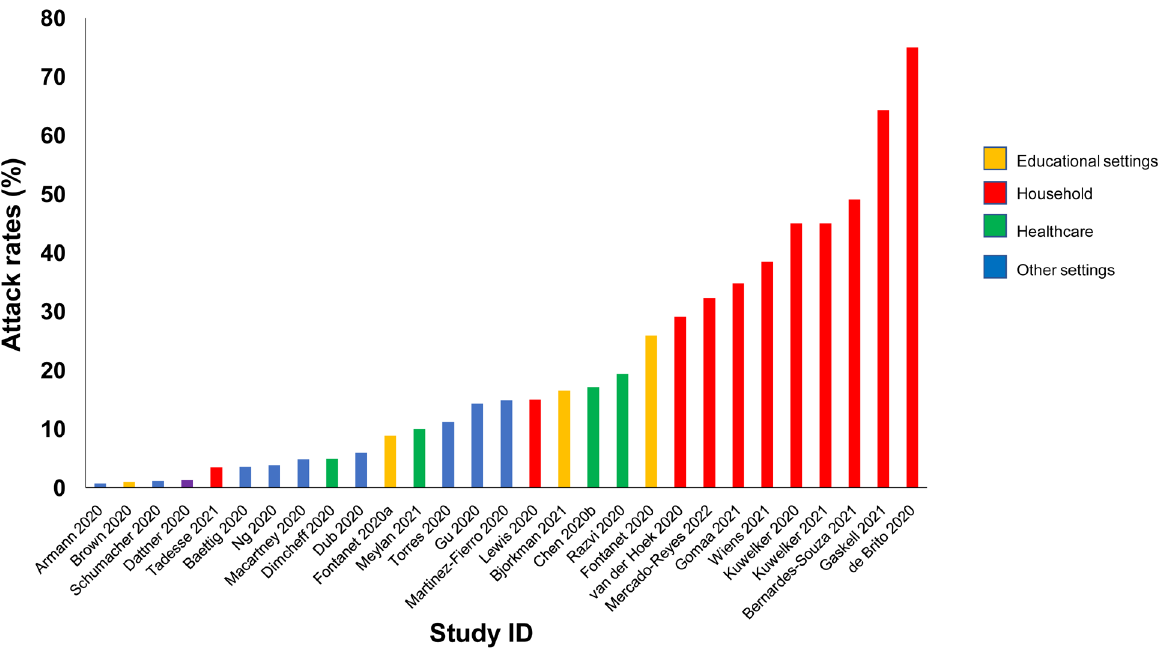
Figure 3b. Primary attack rates of SARS-CoV-2 in close contacts (serology).